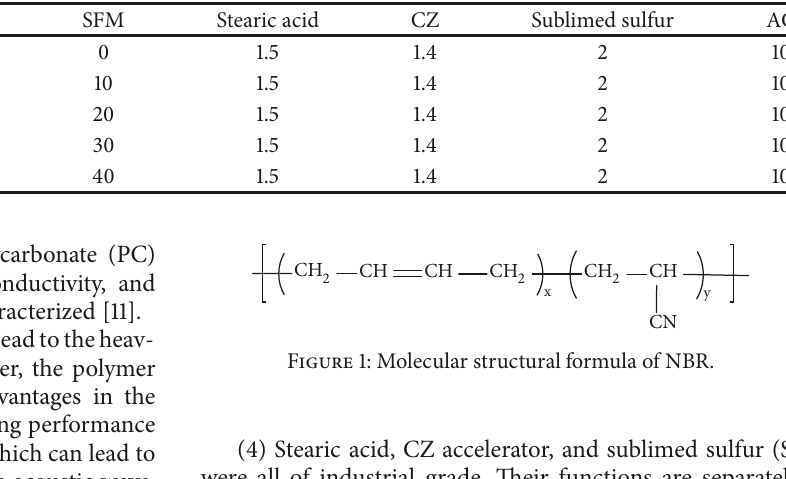
Table 1: Formulations of SFM/NBR-PVC microcellular foaming materials.